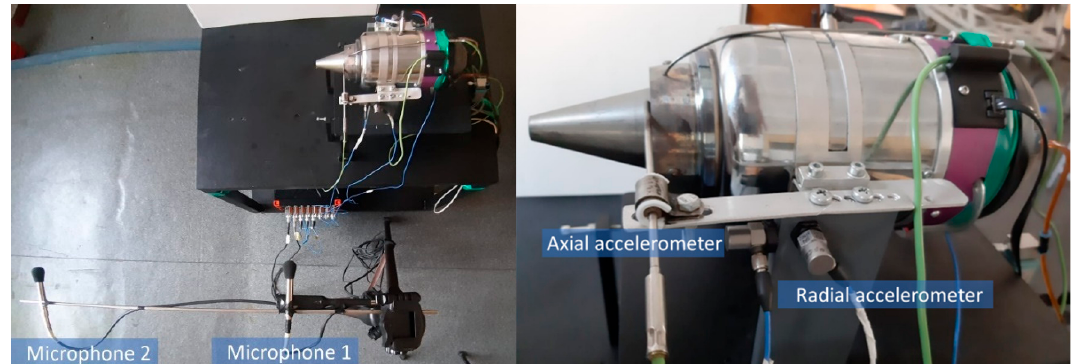
Figure 1. Test bench instrumentation (microphones and accelerometers location).